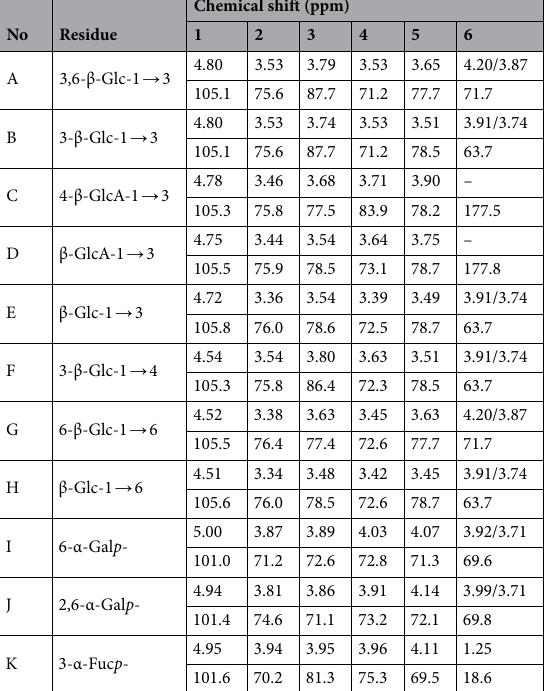
Table 2. NMR chemical shift assignments for the residues found in EtGIPL1a. The residues that were not found in EtISPFa 5 are I, J and K.